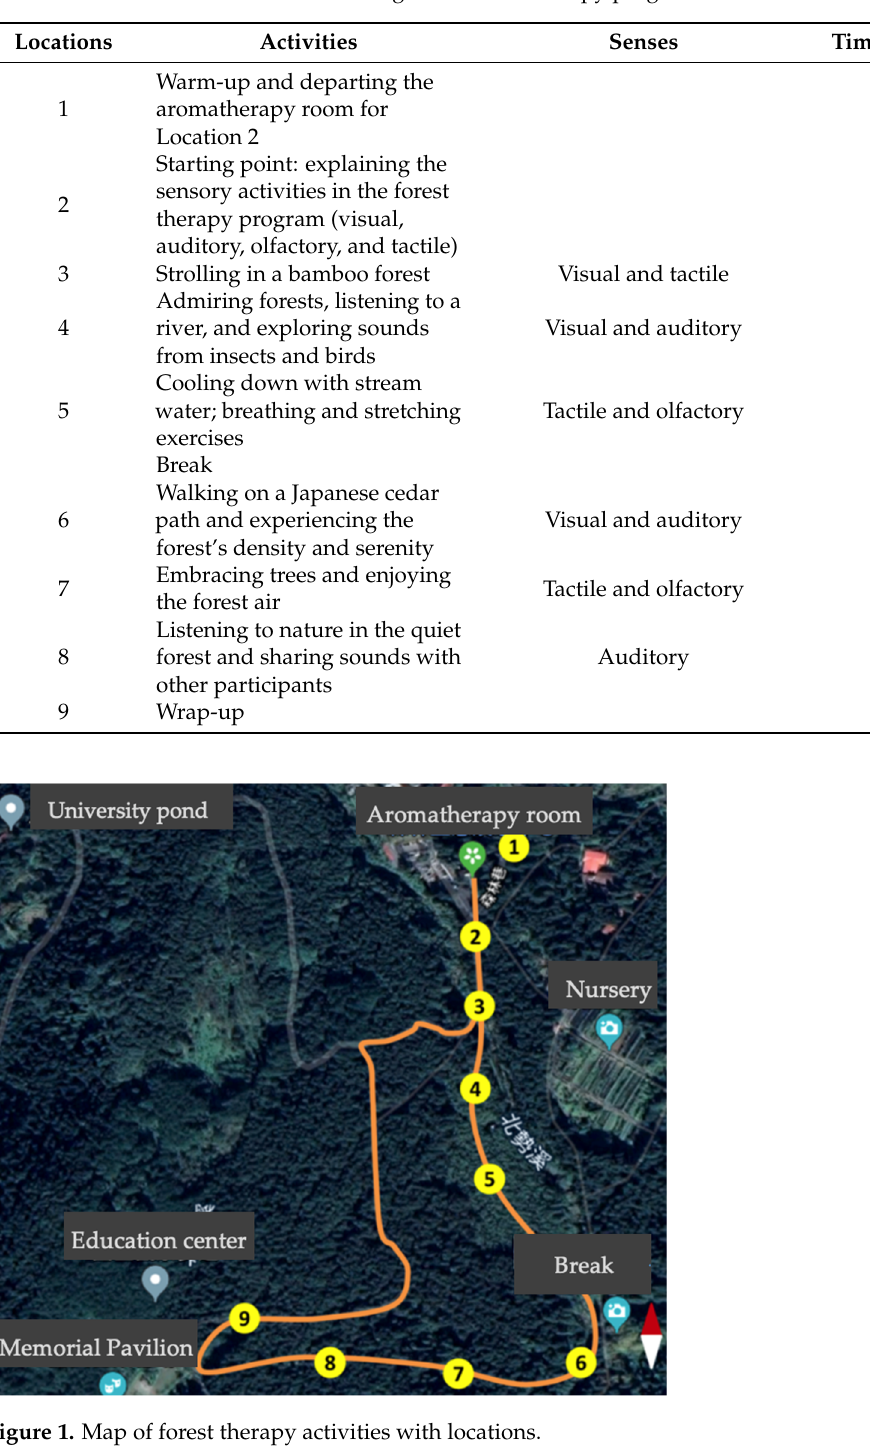
Table 2. Timeframe and activities for the guided forest therapy program.